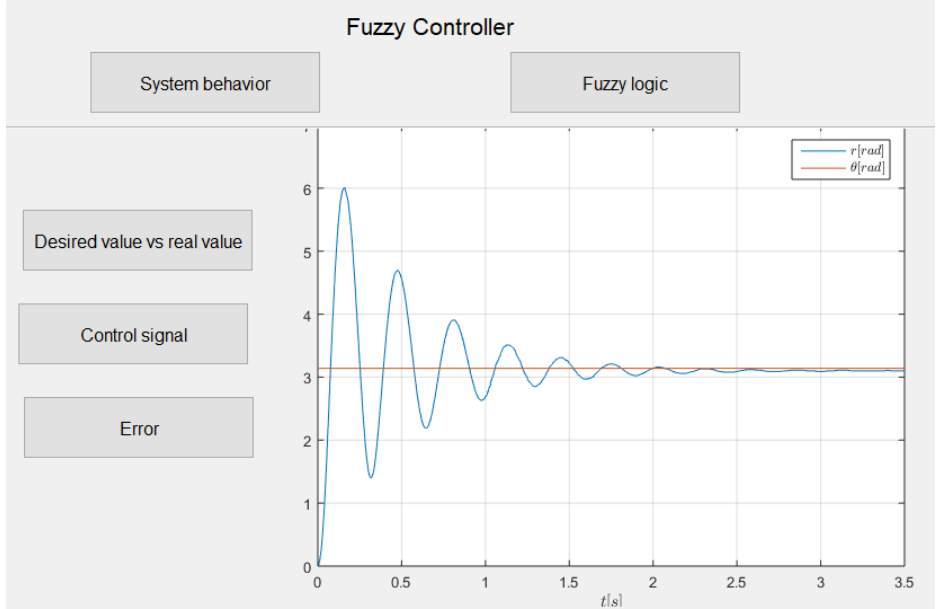
Figure 4. GUI screen for system